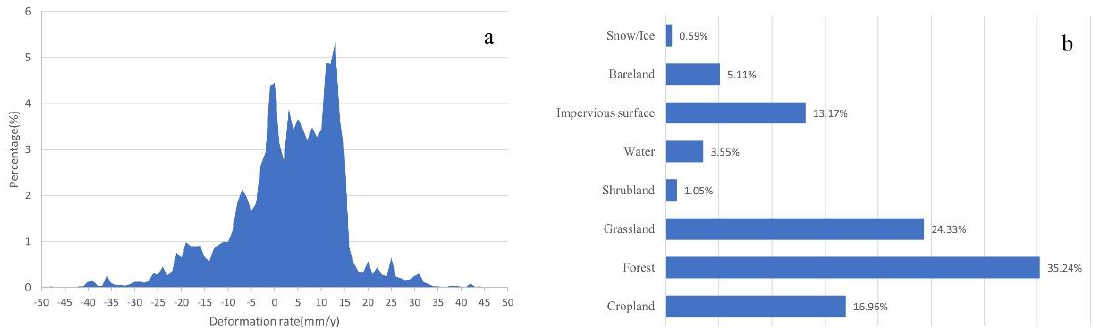
Figure 6. The distribution of scatter points. ( a ) the annual deformation rate of them; ( b ) the land cover of scatter points.